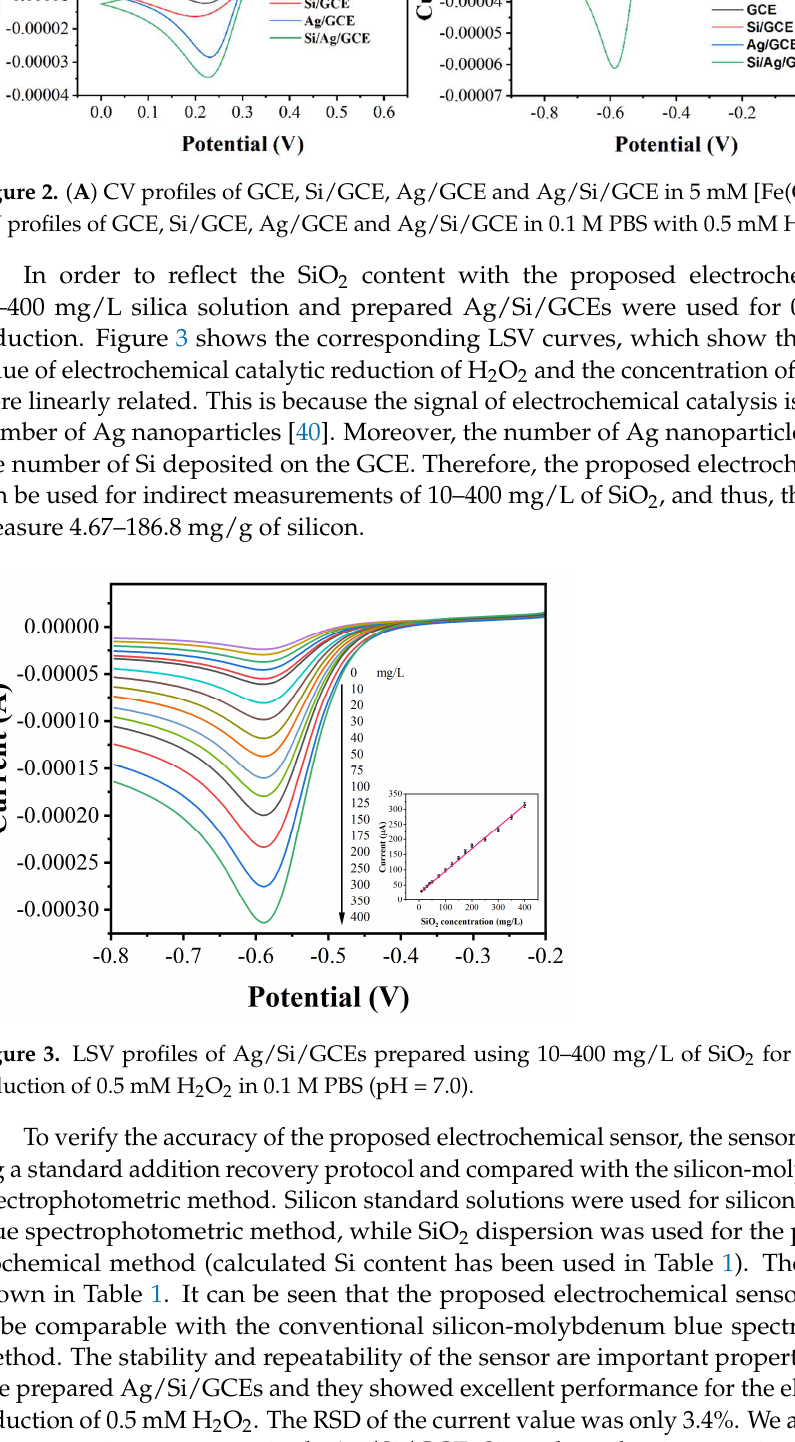
Figure 3. LSV profiles of Ag/Si/GCEs prepared using 10–400 mg/L of SiO 2 for electrocatalytic re- duction of 0.5 mM H 2 O 2 in 0.1 M PBS (pH = 7.0).